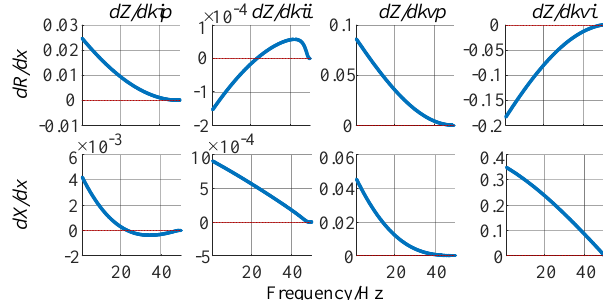
Figure 7. Influence of cascaded voltage – current control parameters on the impedance characteristics of VSG controlled converters.